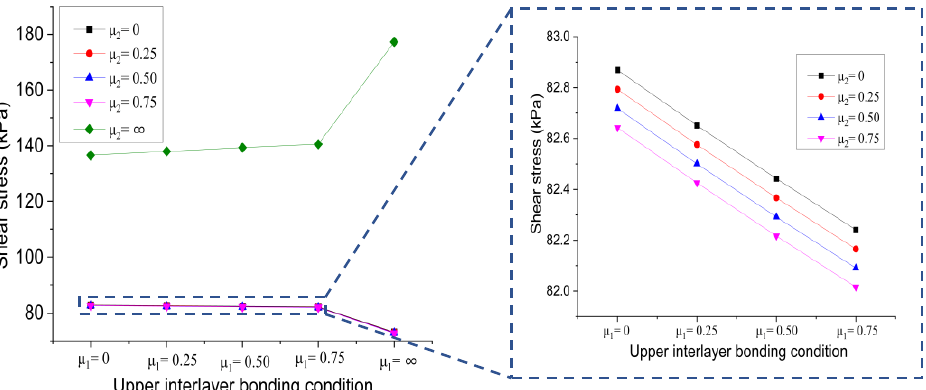
Figure 12. Influence of upper interlayer bonding condition on shear stress at the bottom of lower layer.